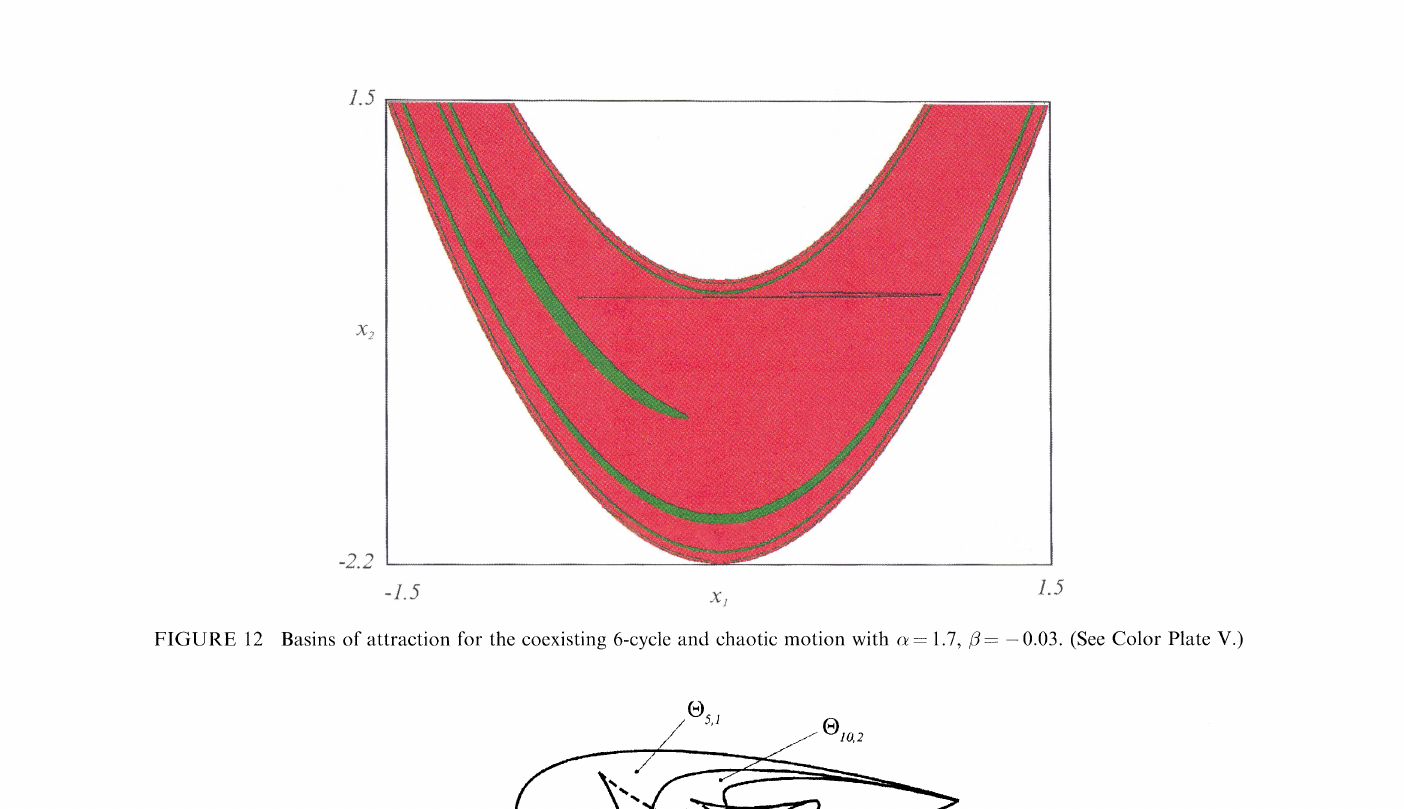
FIGURE 12 Basins of attraction for the coexisting 6-cycle and chaotic motion with s =1 .7, fl = -0.03 . (See Color Plate V .)